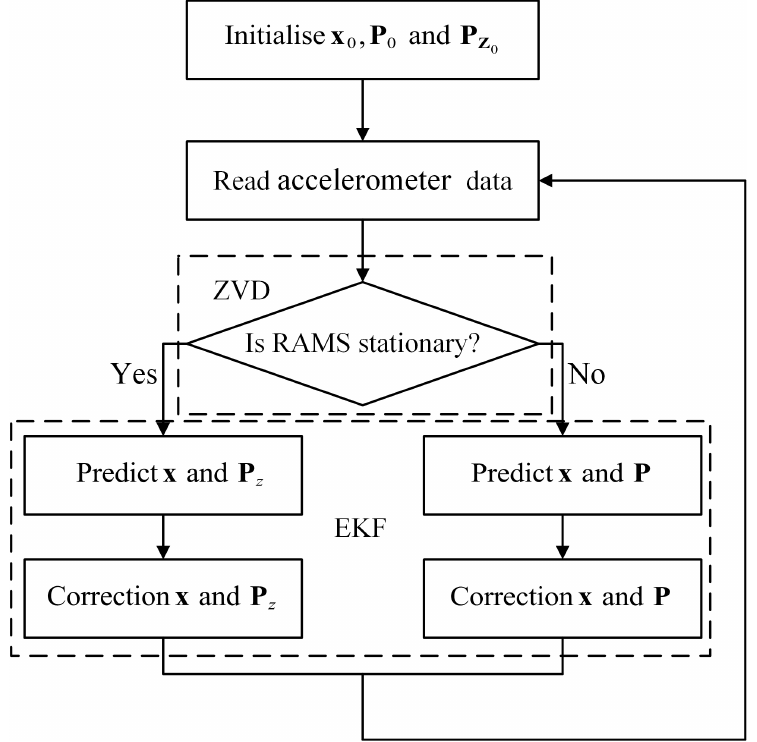
Figure 8. Complete procedure of rotation angle